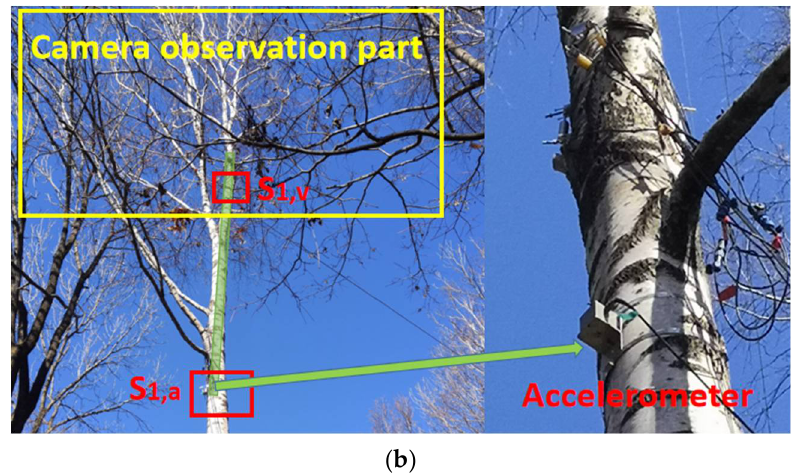
Figure 2. ( a ) The positions of S 1,v , S 2,v and anemometer tower in the camera image; ( b ) Positions of S 1,a and S 1,v .